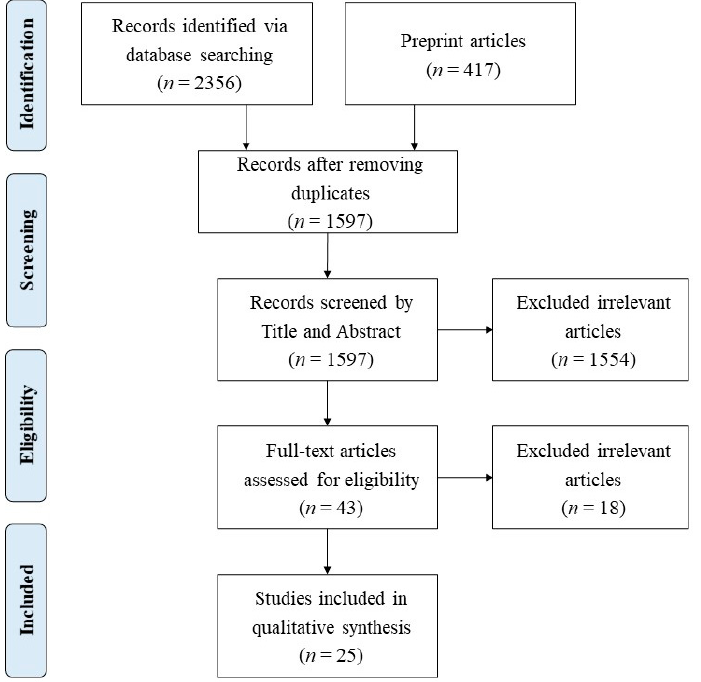
Figure 1. The workflow diagram based on Preferred Reporting Items for Systematic Reviews and Meta-Analyses study selection method.